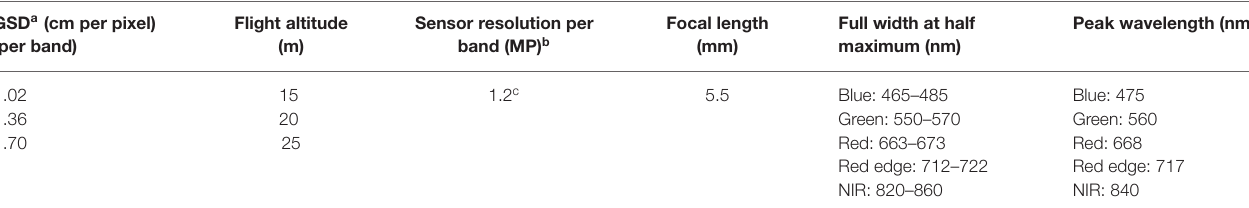
TABLE 2 | Basic specifications for the multispectral camera (RedEdge) equipped on the unmanned aerial vehicle (UAV) platforms. GSD a (cm per pixel) (per